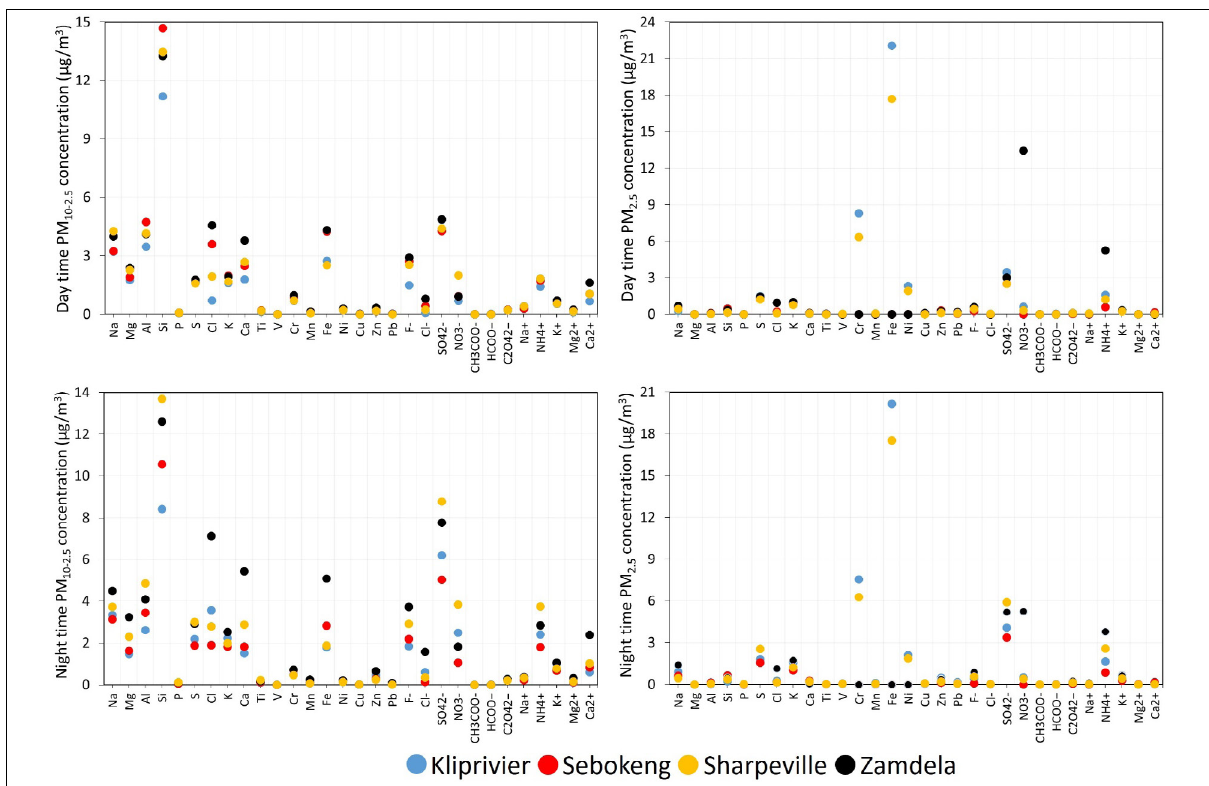
and PM at all the 10-2.5 2.5